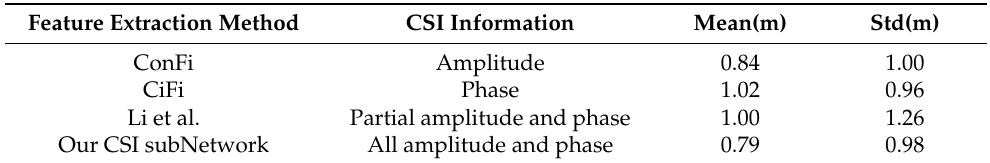
Table 1. Comparison of different CSI feature extraction methods. Although the positioning standard deviation of our method is slightly higher than that of CiFi, the positioning mean error of our method is much lower than that of